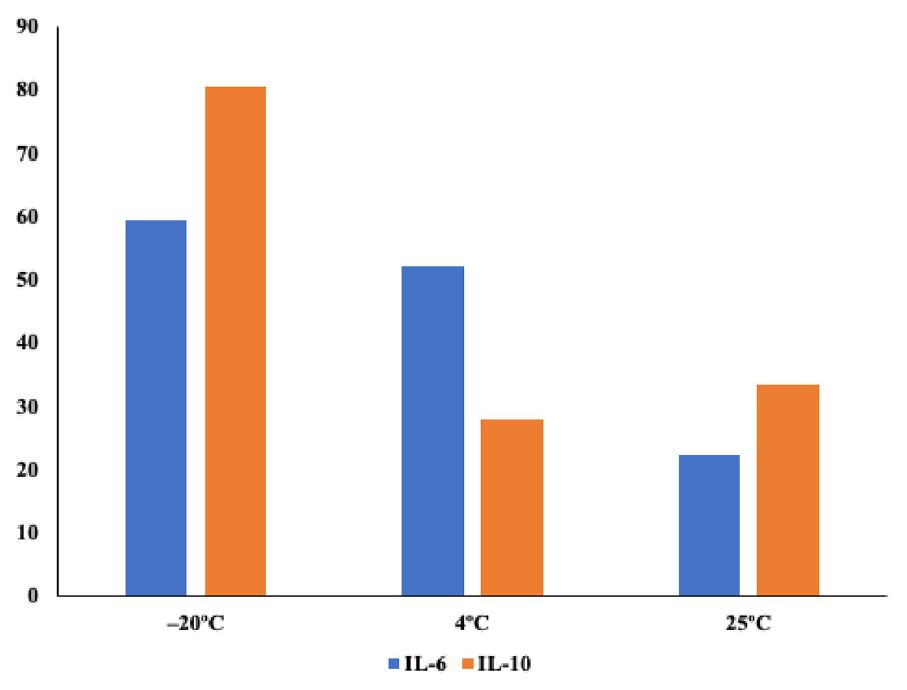
Fig 5. Proportions of specimens with detectable levels of IL-6 or IL-10 after a 14-day storage at –20˚C, 4˚C or 25˚C.